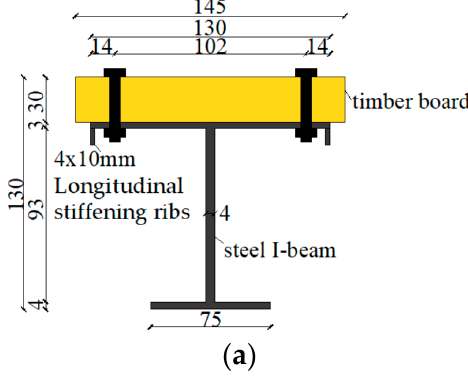
Figure 1. Cross-section bolt arrangement structure of L1–L4 test specimens (unit: mm): ( a ) L1 group cross-section bolt layout structure; ( b ) Layout and structure of L2–L4 group cross-section bolts (Note: L3-1 test specimen has no longitudinal stiffening ribs).